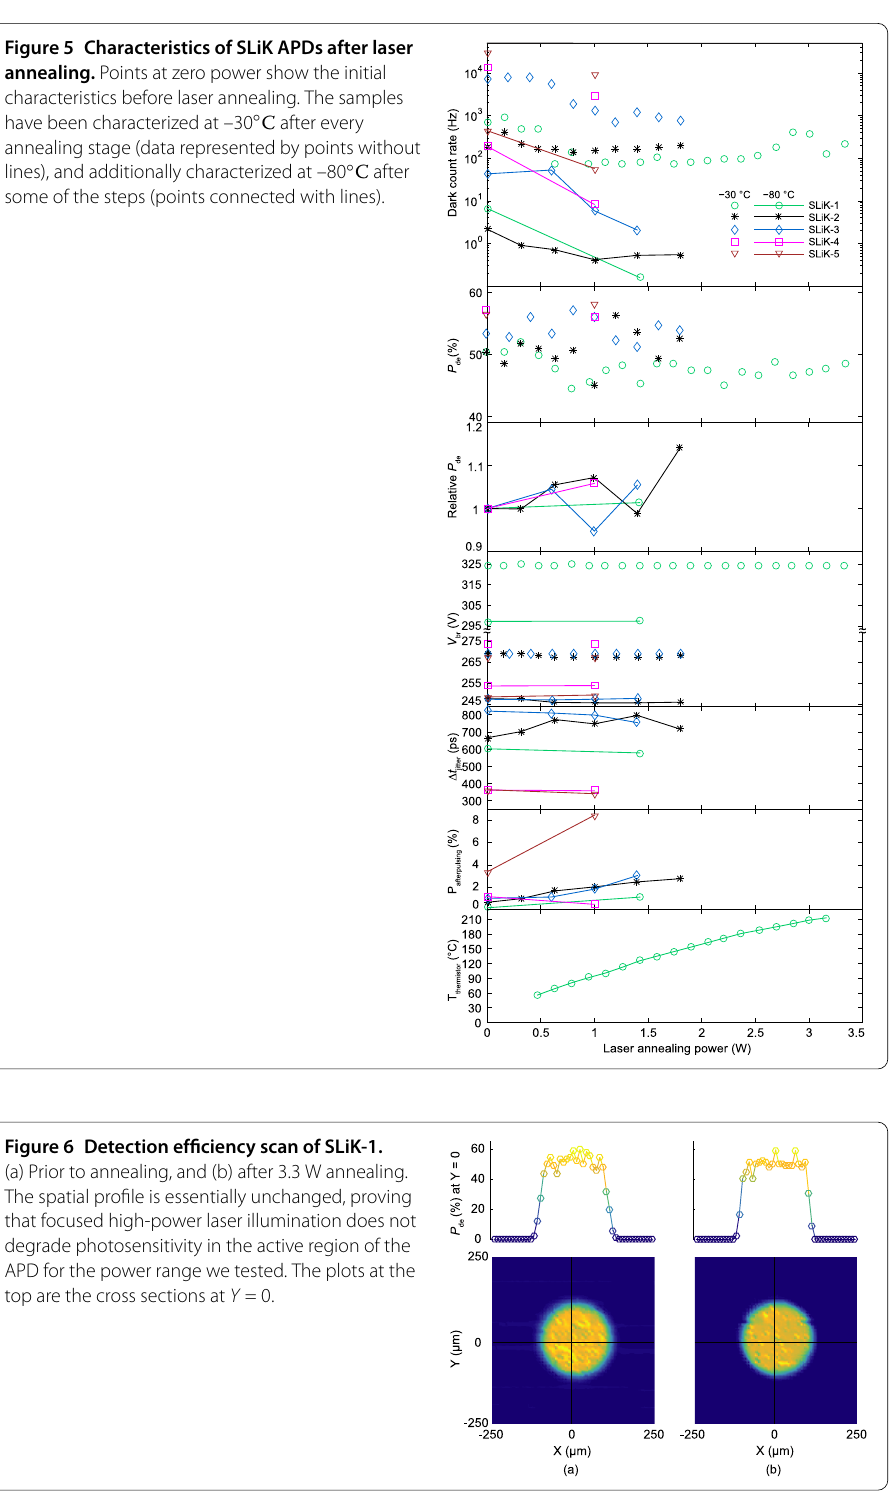
Figure 5 Characteristics of SLiK APDs after laser annealing. Points at zero power show the initial characteristics before laser annealing. The samples have been characterized at –30 ◦ C after every annealing stage (data represented by points without lines), and additionally characterized at –80 ◦ C after some of the steps (points connected with lines).